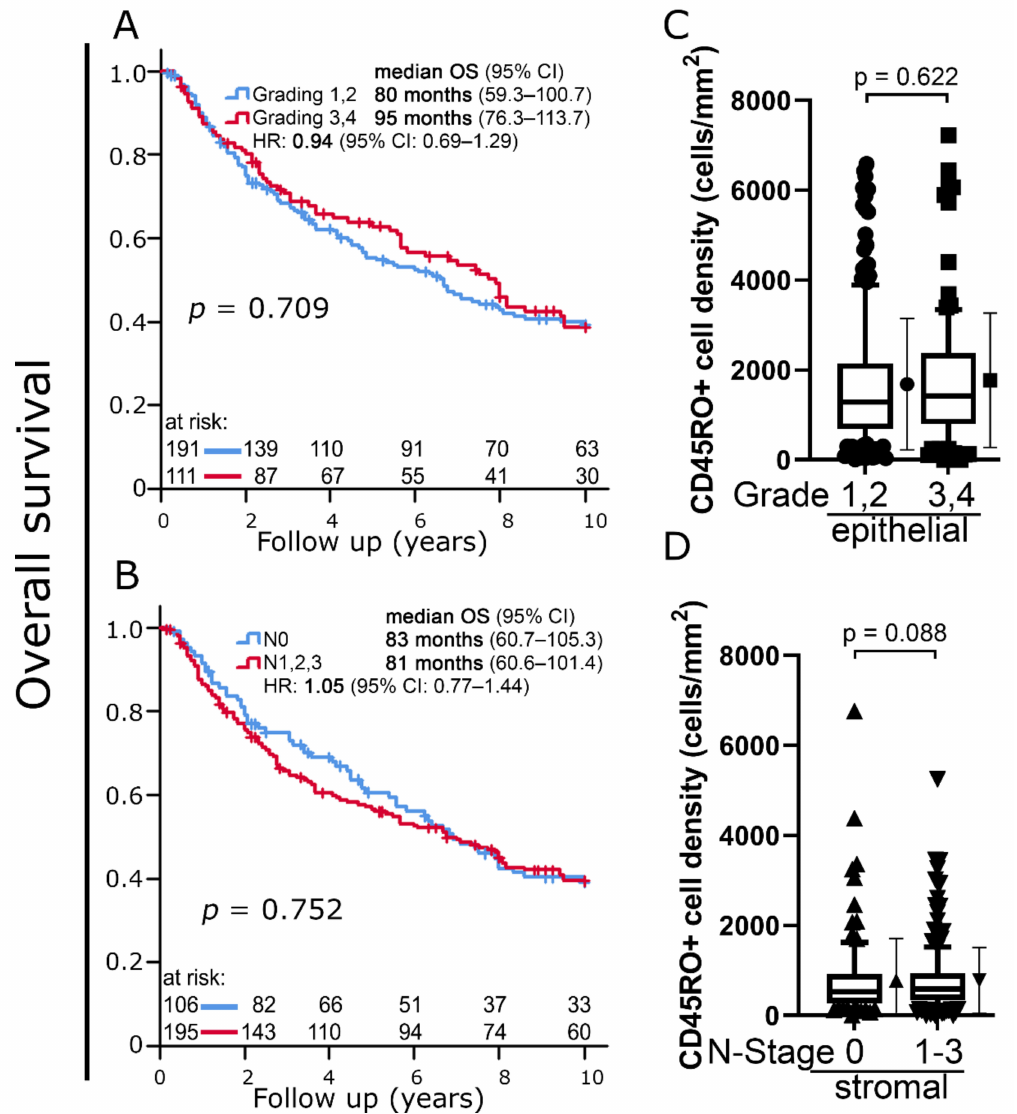
Figure 3. ( A , B ) Kaplan–Meier plots of 10-year overall survival according to ( A ) histologic grading and ( B ) lymph node status. ( C ) Boxplots of CD45RO+ cell densities in the intraepithelial compartment according to histologic grading. ( D ) Boxplots of CD45RO+ cell densities in the stromal compartment according to lymph node status. Student’s t -test was used to compare groups.